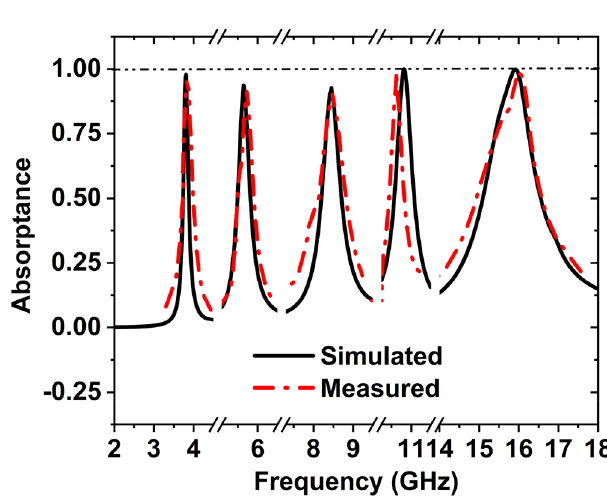
Figure 24. Simulated and measured absorption graph of the MAA nit